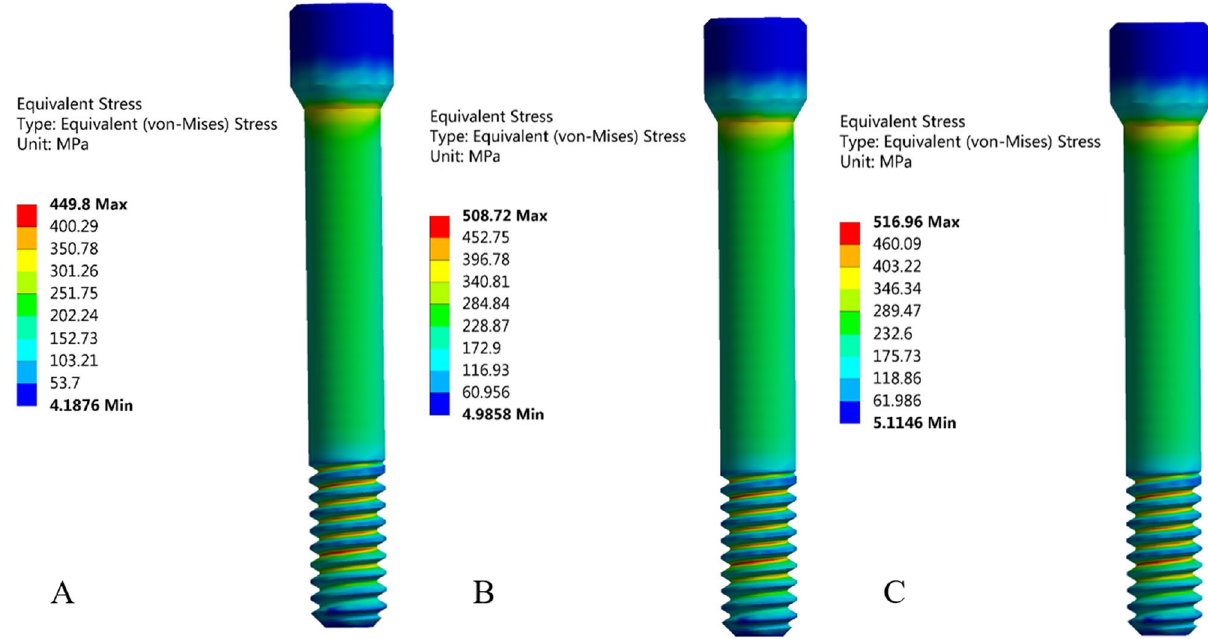
Figure 9. Equivalent stress distribution of the abutment screws. ( A ) NC group, ( B ) SC group, and ( C ) MC group.